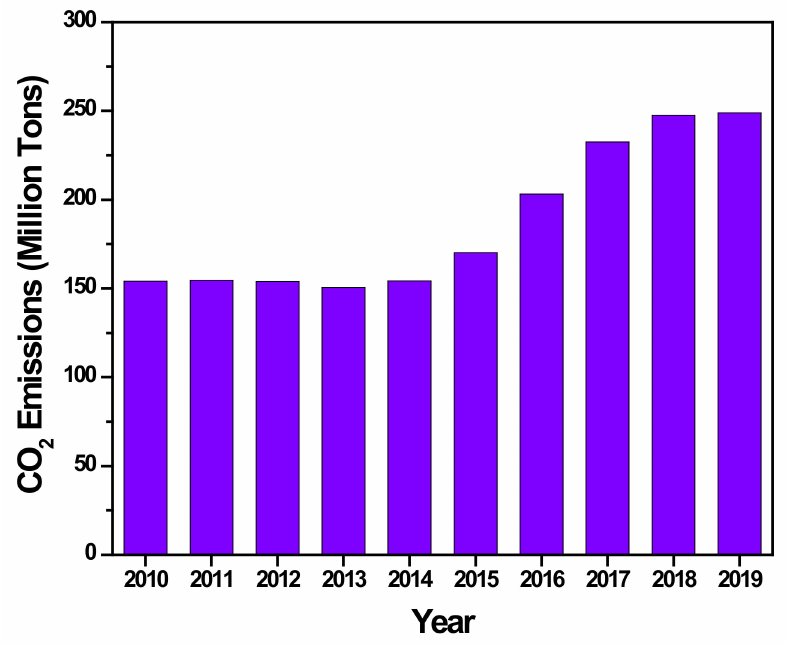
Figure 9. The CO 2 emissions in Pakistan from 2010 to 2019